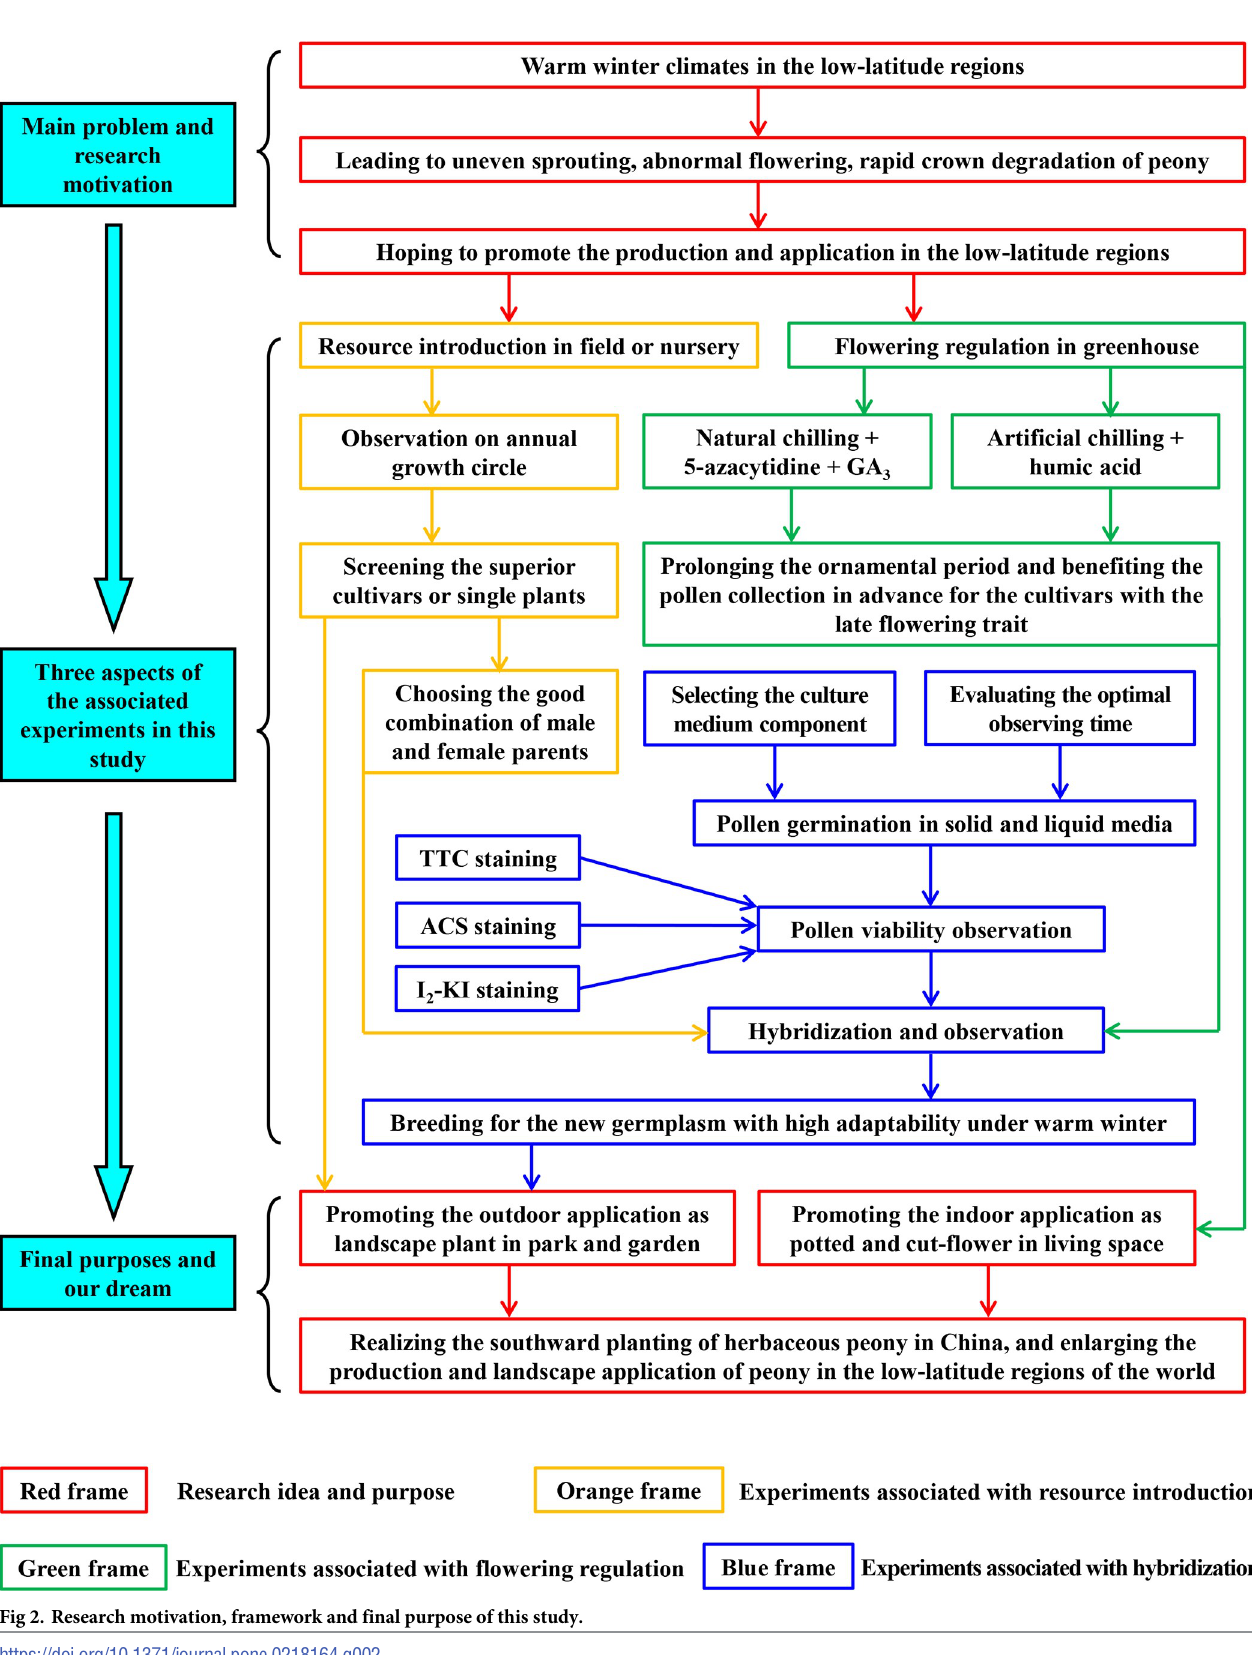
Fig 2. Research motivation, framework and final purpose of this study.